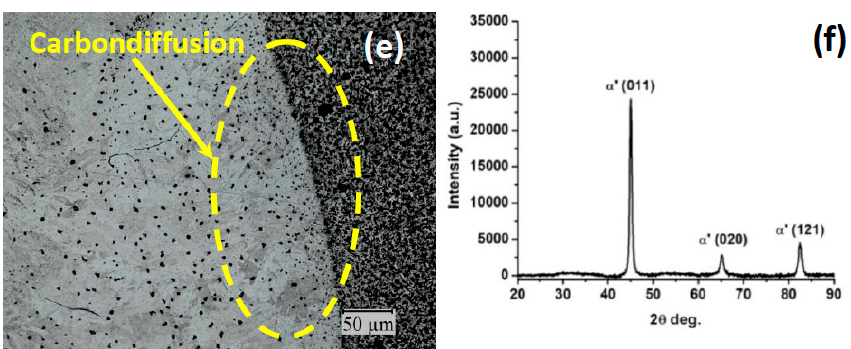
Figure 3. Microstructure of: ( a ) EN 8 without clad; ( b ) retained austenite (lath martensite and whitish spots); ( c ) middle layer of the clad with refined grains; ( d ) bottom layer of the clad carbon diffusion; ( e ) fusion zone of clad and base metal; and ( f ) XRD analysis of top layer showing presence of martensite.